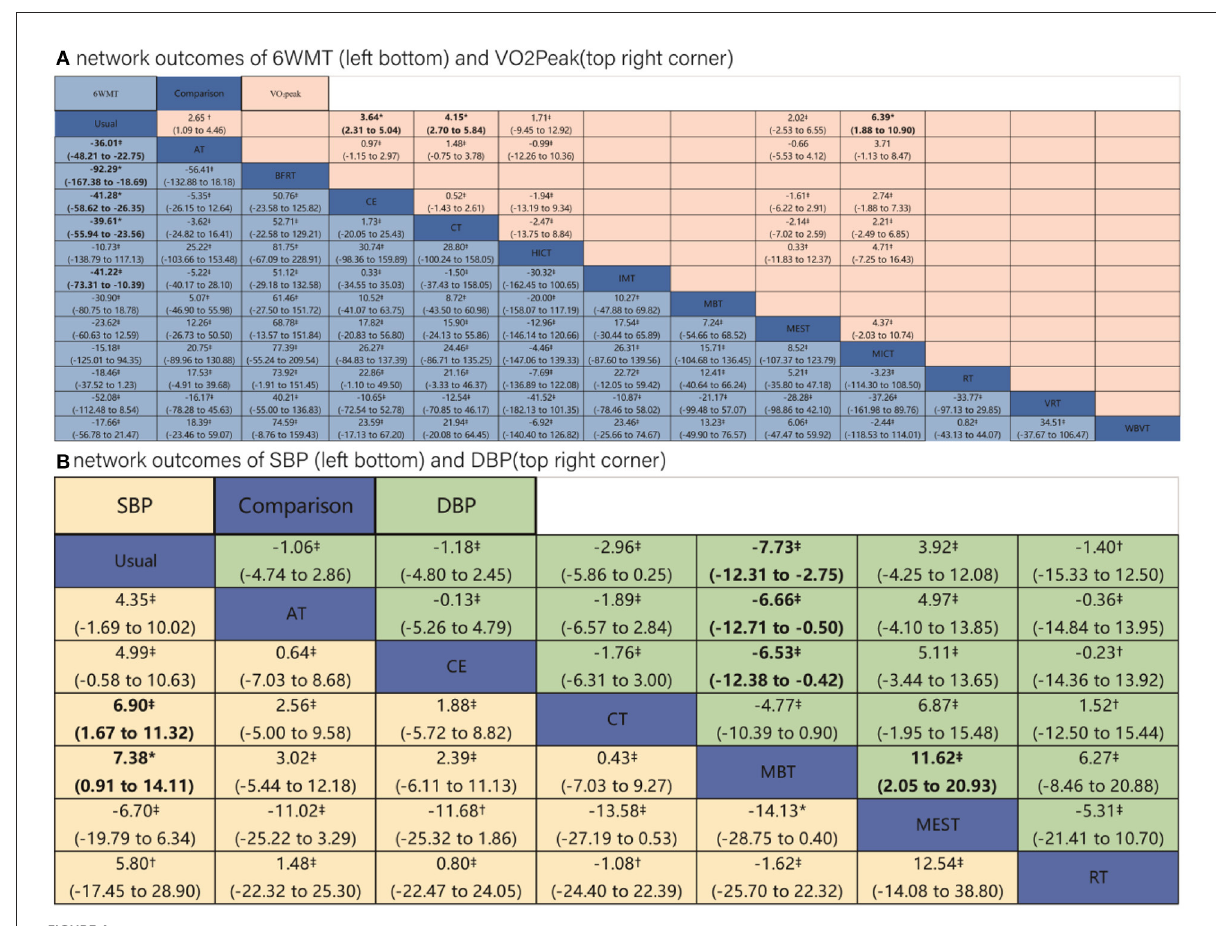
FIGURE4 Results of network meta-analysis of four outcomes. Comparisons should be read from left to right. (A) Outcomes of 6 WMT and VO 2 Peak. (B) Outcomes of SBP and DBP. Outcomes are located at the intersection between the column-defining treatment and the row-defining treatment. Data are in MD (95% CIs). For 6MWT and VO 2 Peak, MDs above 0 favor the column-defining treatment. For SBP and DBP, MDs below 0 favor the column-defining treatment. The certainty of the evidence [according to confidence in network meta-analysis (CINeMA)] was incorporated in this figure as footnotes. * Moderate quality of evidence. † Low quality of evidence. ‡ Very low quality of evidence. The significant results in league tables have been bolded. AT, aerobic training; Usual, usual care; CT, combined training; RT, resistance training; CE, cycle dynamometers;